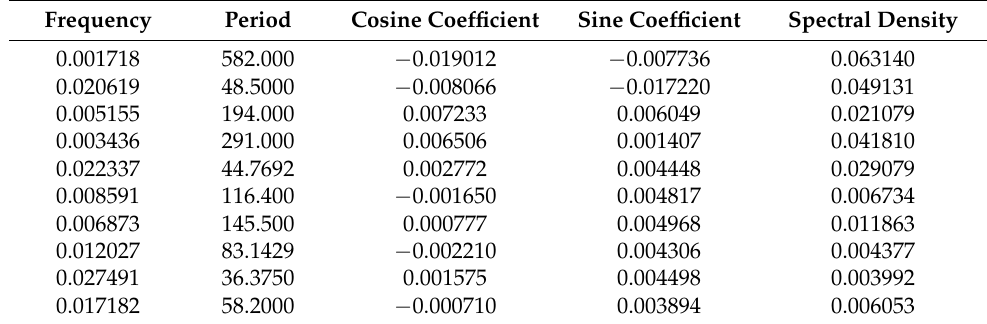
Table 2. First 10 frequencies of measured groundwater oscillations in piezometer V-2/77.